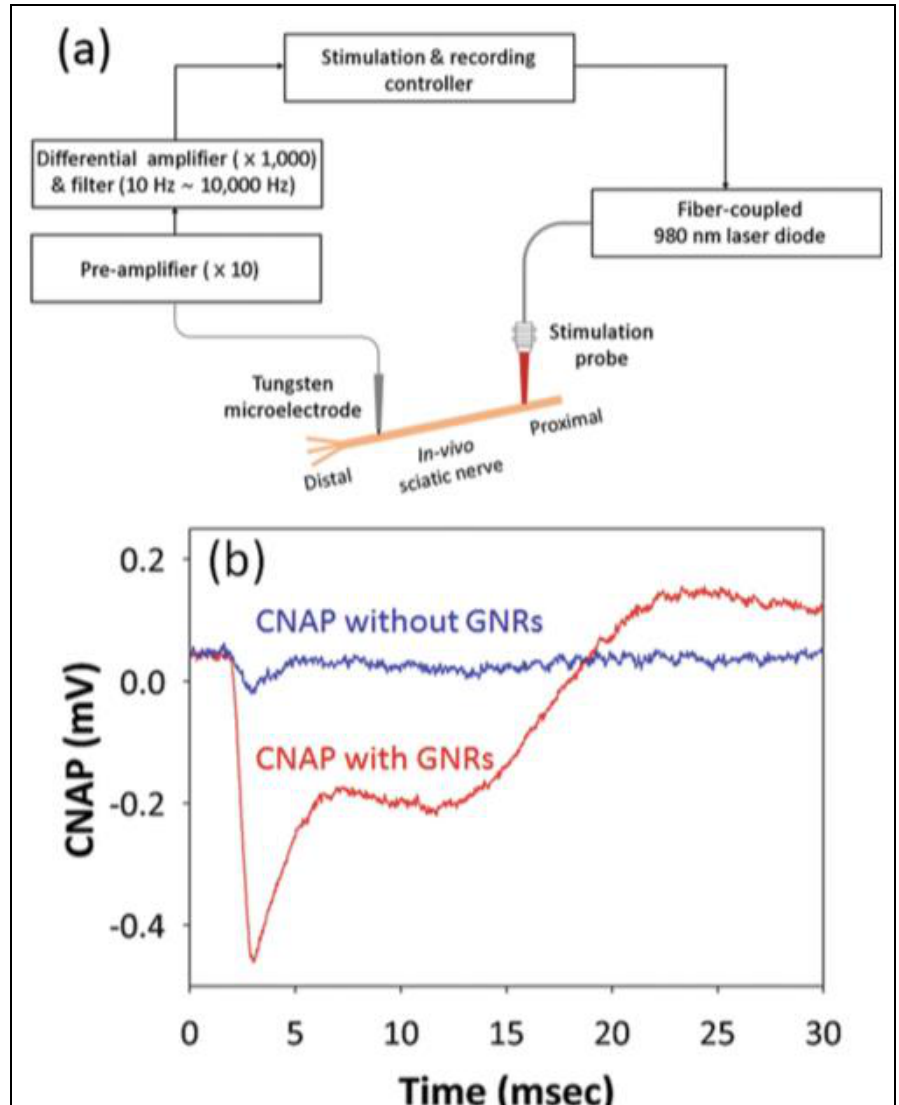
Figure 11. ( a ) a schematic of the experimental setup of in vivo recording of the rat sciatic nerve reactions to PNF activation. ( b ) CNAP curves recorded after laser exposure with and without PNF. Reproduced with permission from [15]. John Wiley and Sons, 2014.